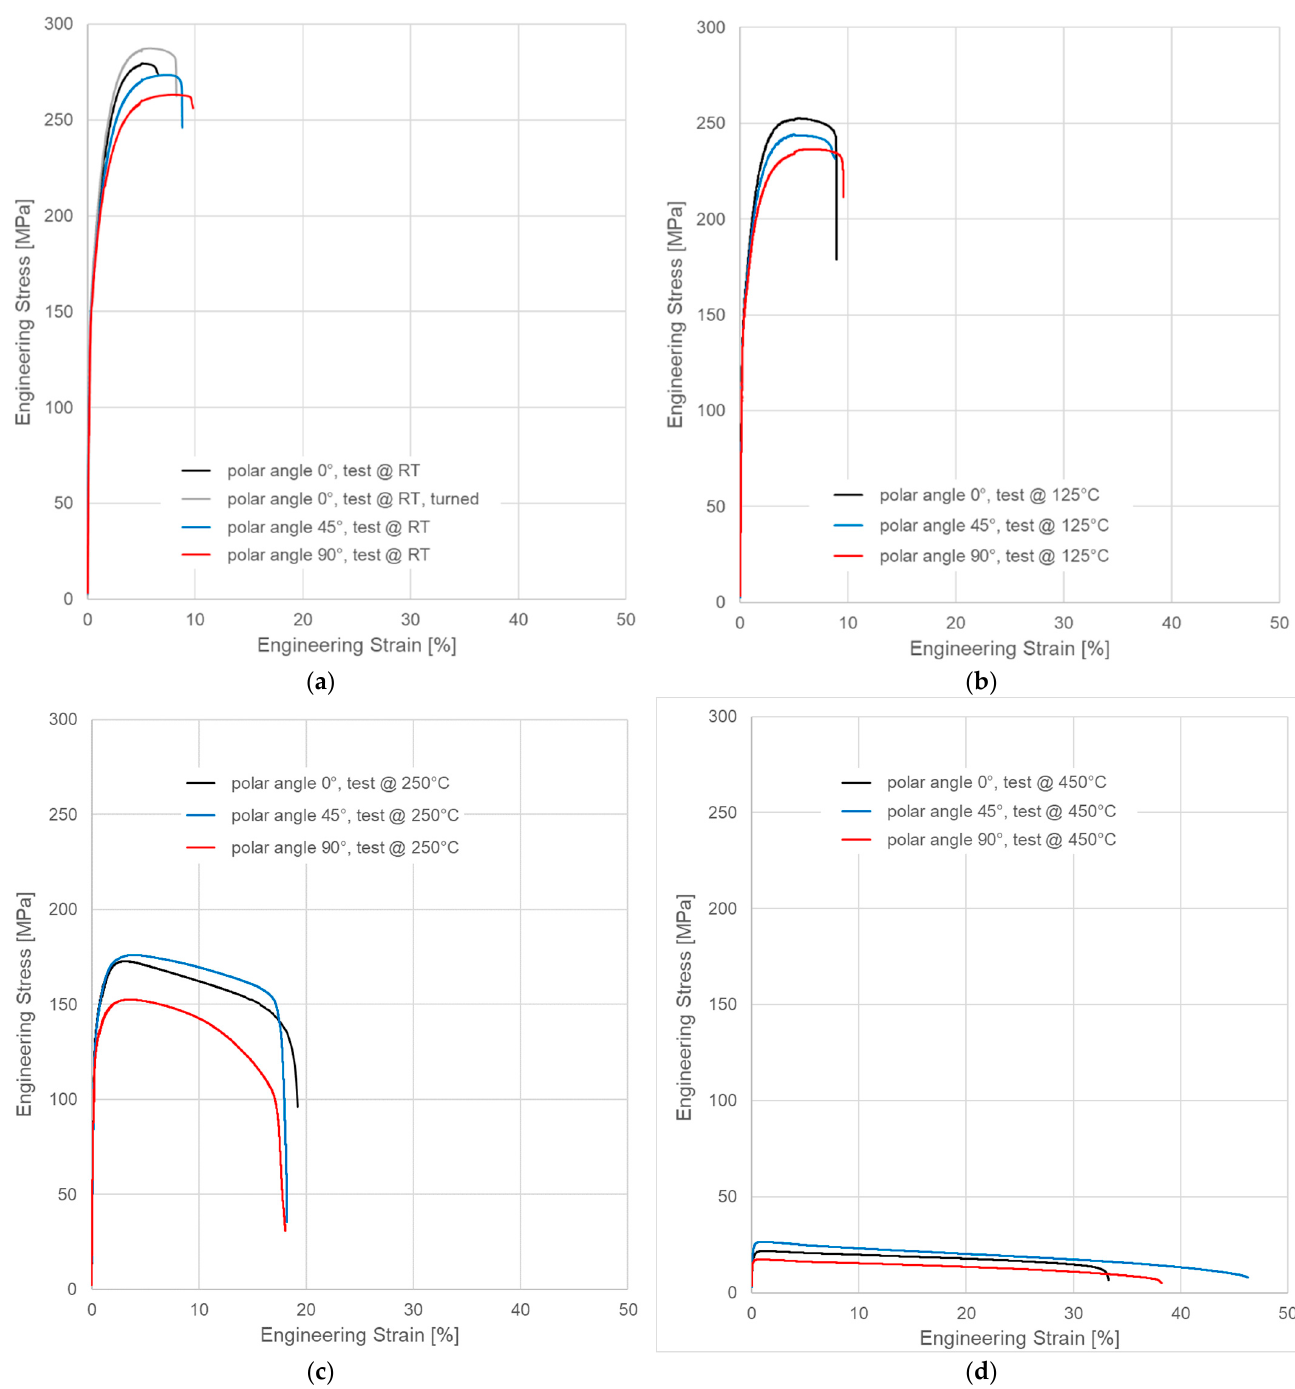
Figure 4. Representative engineering stress vs. strain curves for different build orientations and test temperatures: ( a ) room temperature data, ( b ) test temperature 125 ◦ C, ( c ) test temperature 250 ◦ C and ( d ) test temperature 450 ◦ C. Note that x - and y -axis scaling are identical in all cases to allow for direct comparison of the